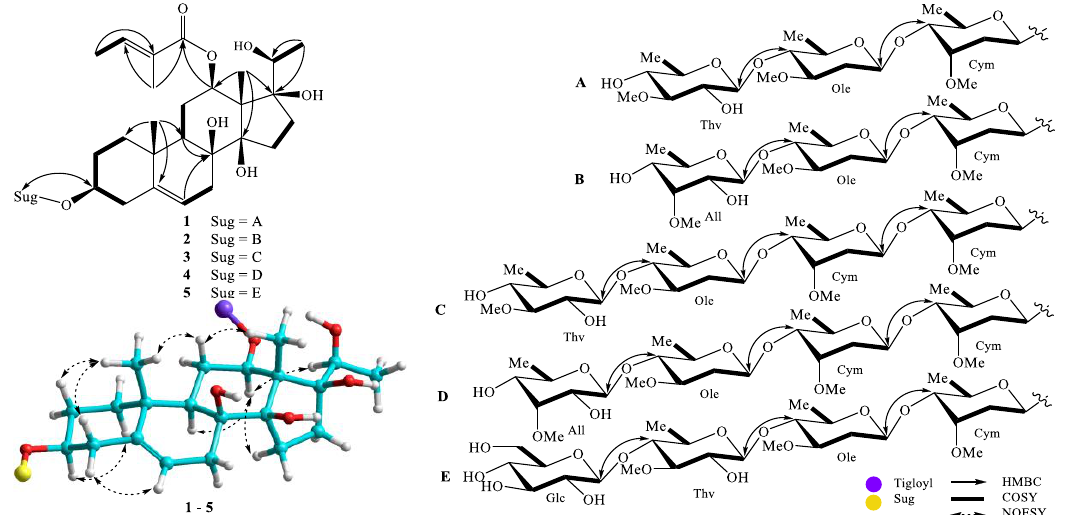
Figure 2. The key HMBC, COSY, and NOESY correlations of compounds 1 – 5.